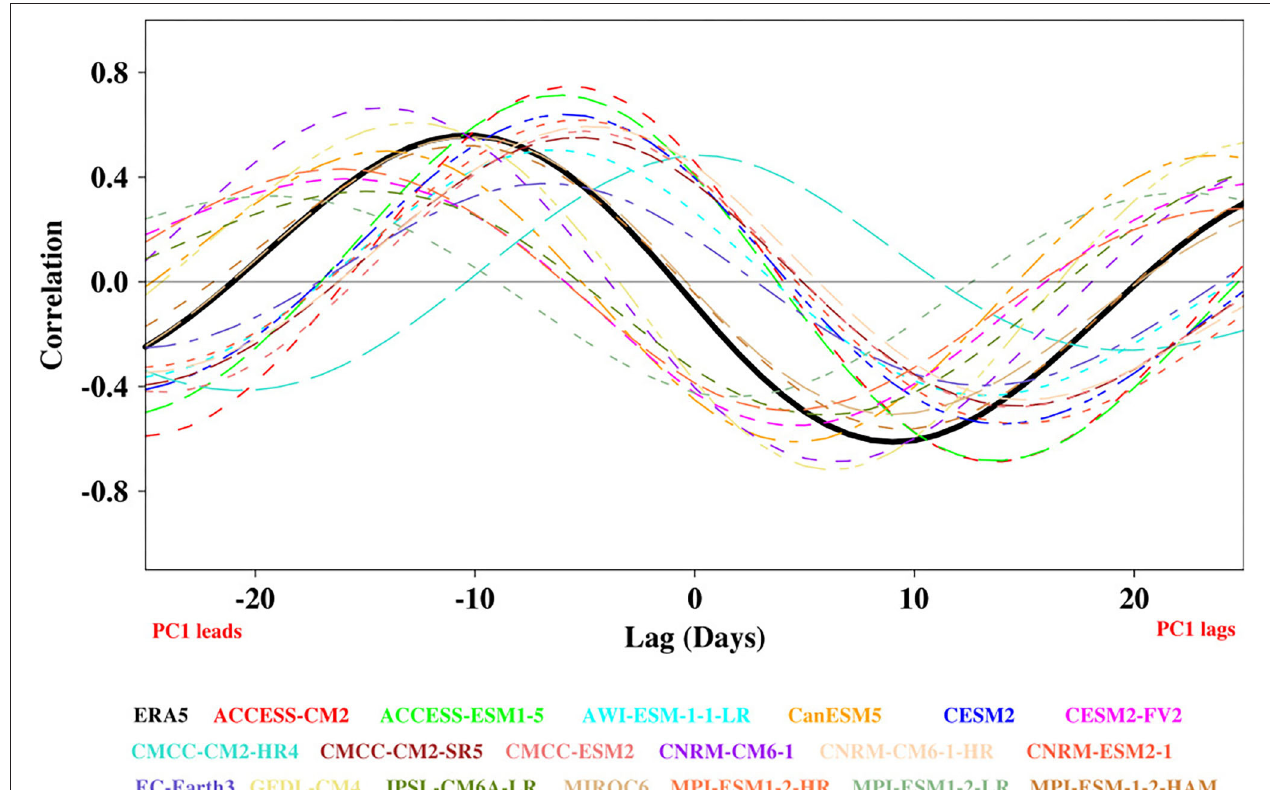
FIGURE 6 | The lag correlation between the first two leading PCs during the boreal summer (May–October) obtained from ERA5 and CMIP6 models for the period 1997–2014.